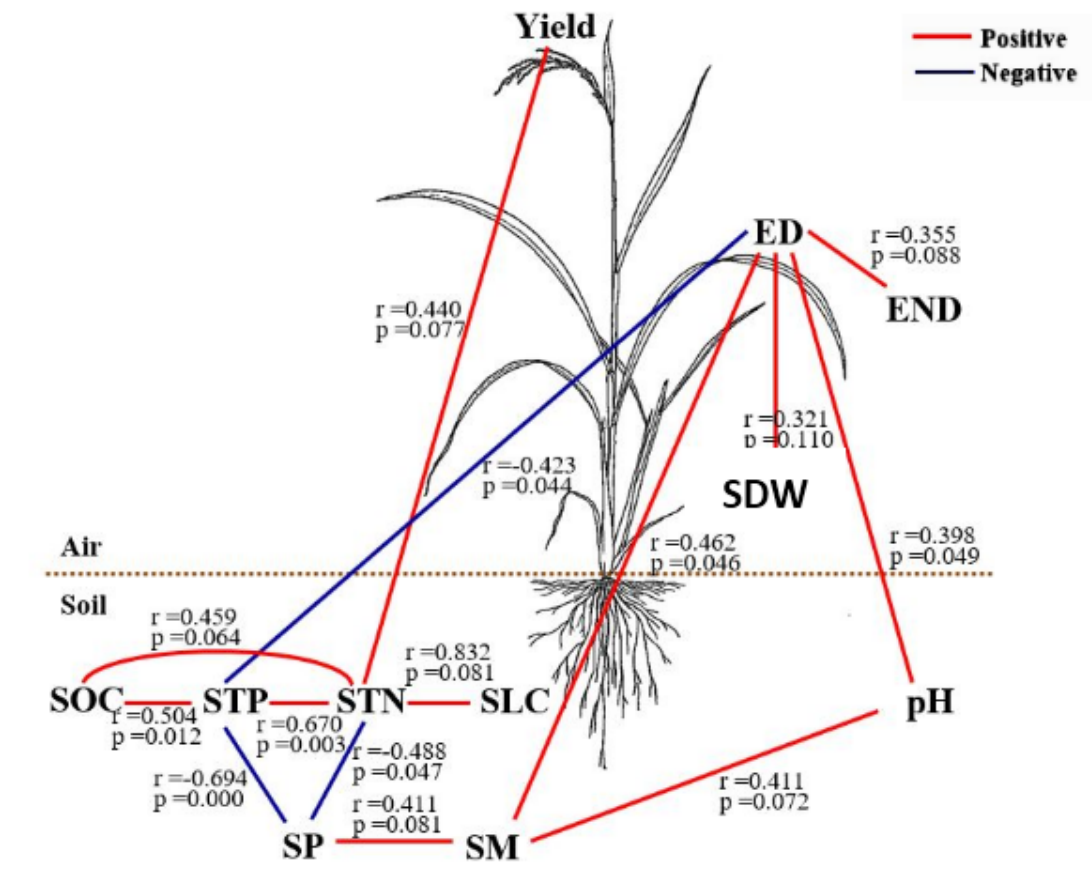
Figure 3: Opened up network of the farmers’ CF